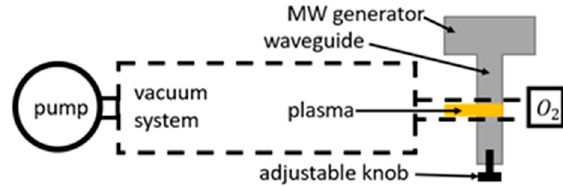
Figure 3. Schematic of a magnetron MW plasma